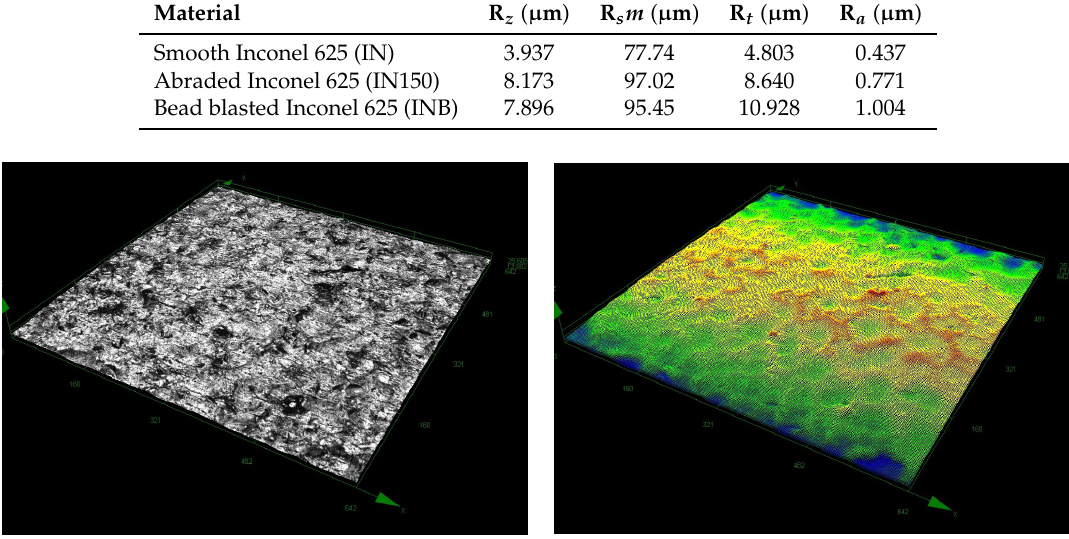
Figure 7. Surface microscopic image of bead blasted Inconel tube.